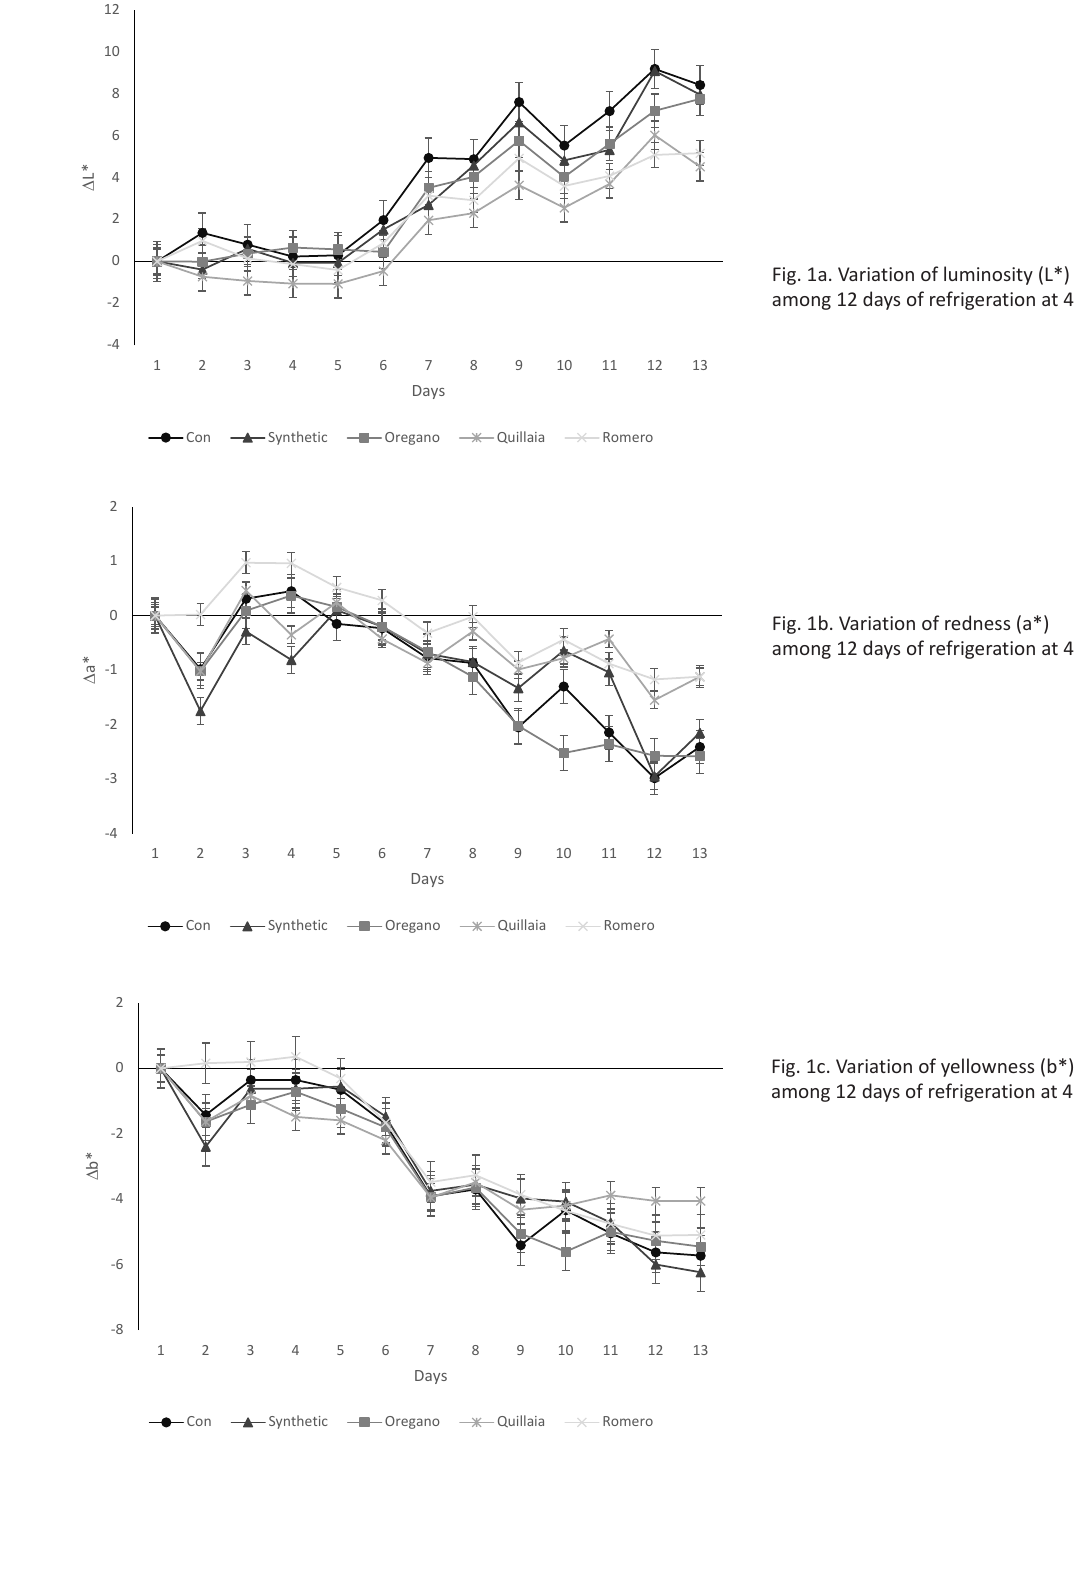
Fig. 1a. Variation of luminosity (L*) among 12 days of refrigeration at 4 °C